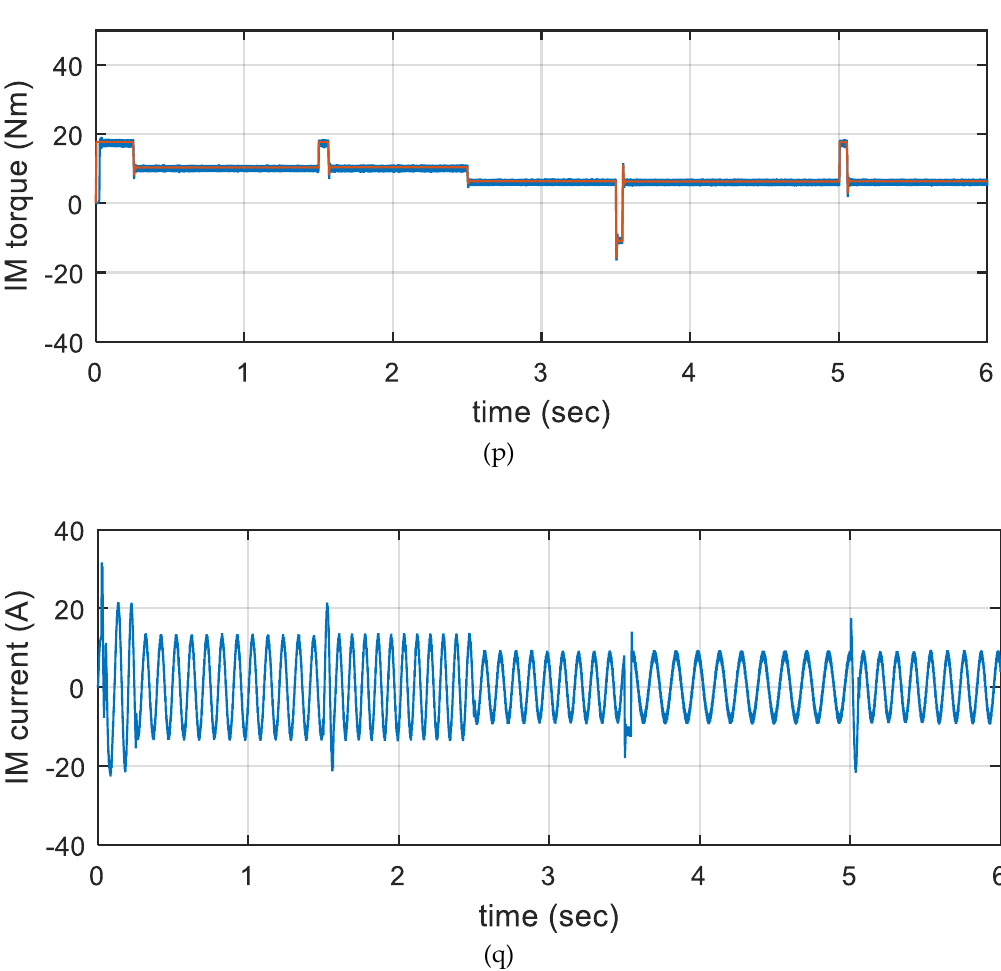
Figure 10. Simulation results of the proposed system. ( a ) Wind velocity, ( b ) IG speed, ( c ) IG torque, ( d ) IG stator current, ( e ) enlarging of ( d ), ( f ) FC pressure of H 2 and O 2 , ( g ) generated power, ( h ) DC-link voltage (pu), ( i ) enlarging of ( h ), ( j ) static load voltage, ( k ) enlarging of ( j ), ( l ) static load current, ( m ) enlarging of ( l ), ( n ) IM speed, ( o ) enlarging of ( n ), ( p ) IM torque, and ( q ) IM stator current.